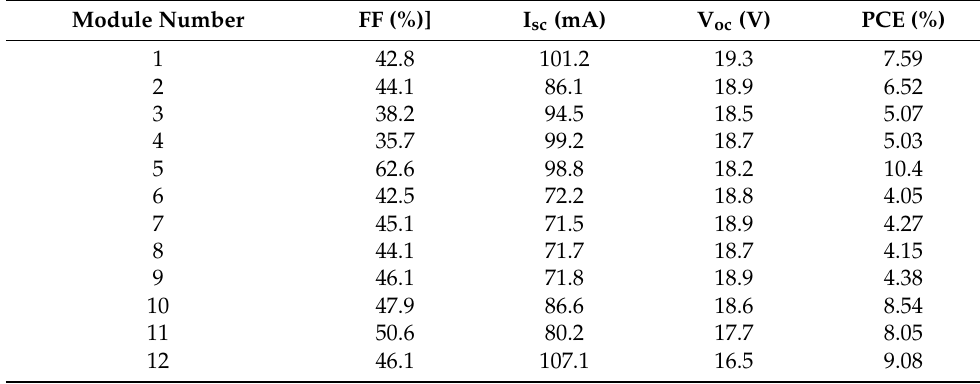
Table 4. Photovoltaic parameters of the 12 modules designed with 18 series of connected cells, each with an active area of 201 cm 2 , assembled in the